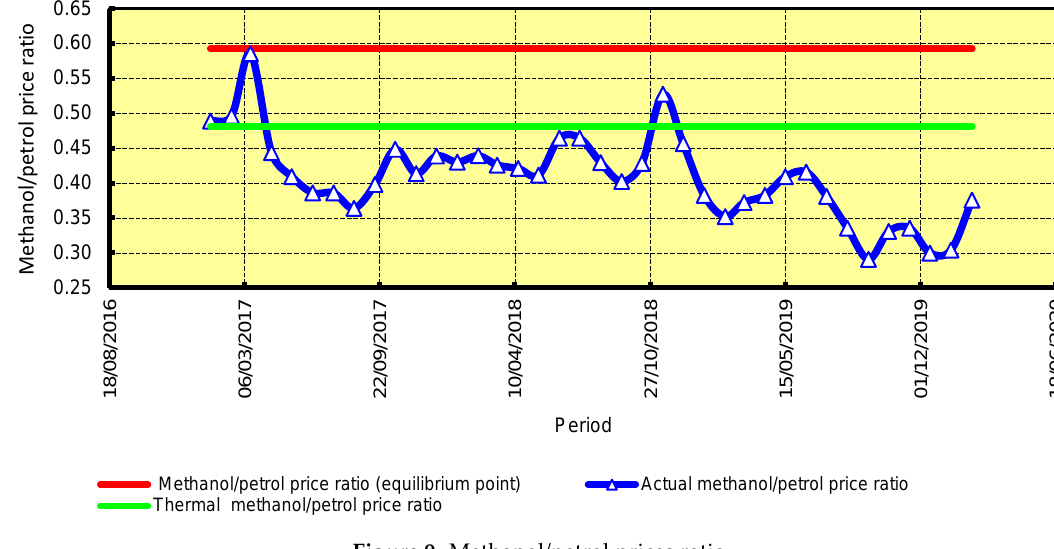
Figure 9. Methanol/petrol prices ratio.